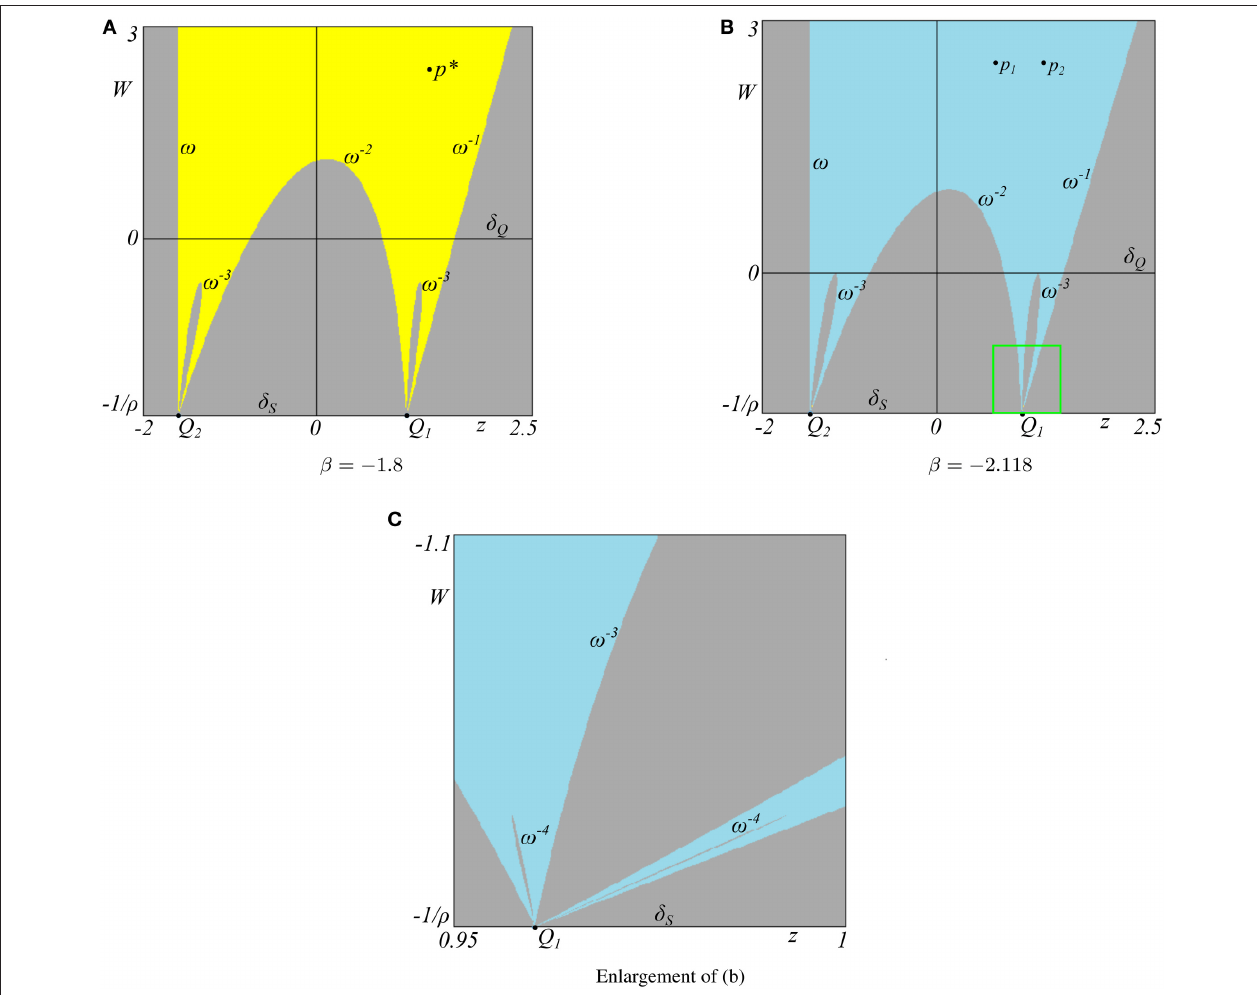
FIGURE 7 | Phase space ( z , W ) of the map T and relative basins of attraction. The yellow basin denotes convergence to the fixed point (A) while the cyan basin denotes convergence to the 2-cycle (B) . In (C) two further lobes issue from the focal point Q 1 . Other parameter values are ρ